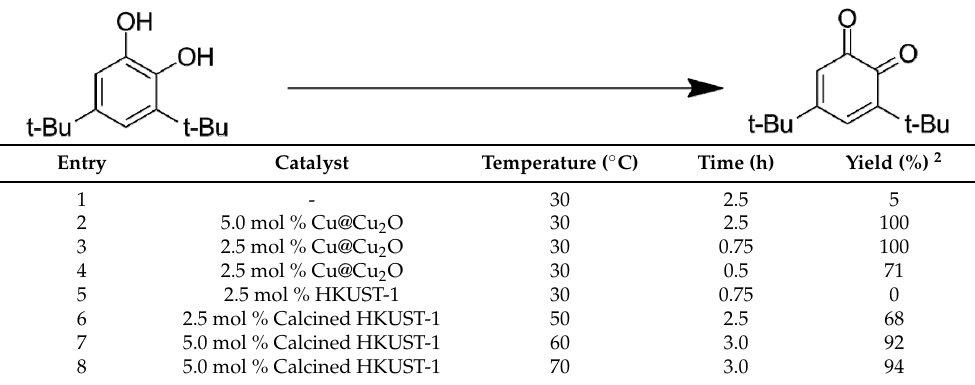
Table 1. Oxidation of 3,5-di- tert -butylcatechol catalyzed by prepared nanoparticles 1